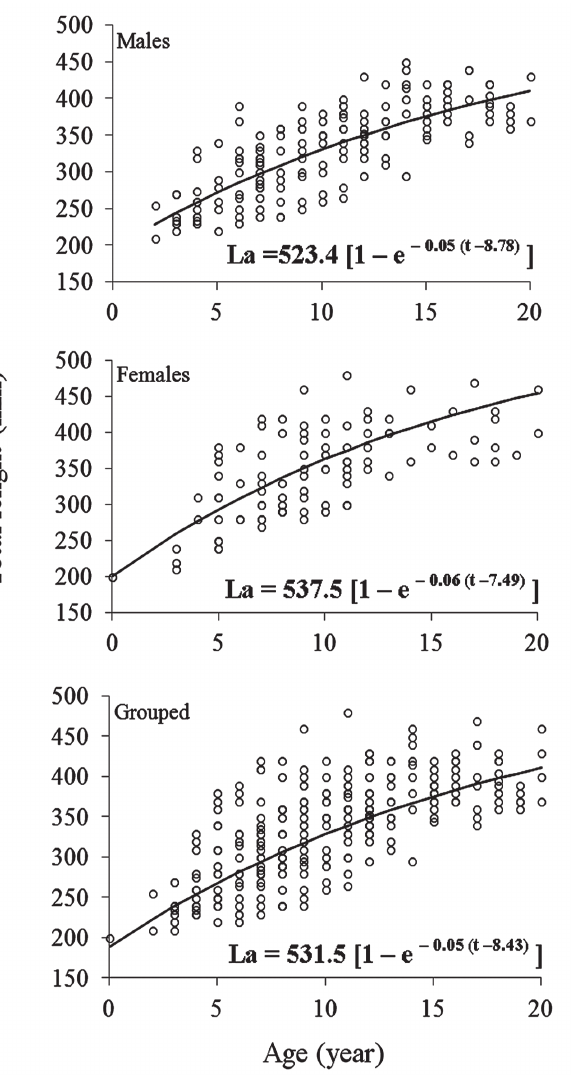
Fig. 5. Growth curves adjusted according to von Bertalanffy models for Micropogonias